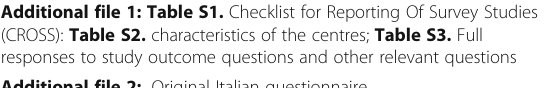
Additional file 1: Table S1. Checklist for Reporting Of Survey Studies (CROSS): Table S2. characteristics of the centres; Table S3. Full responses to study outcome questions and other relevant